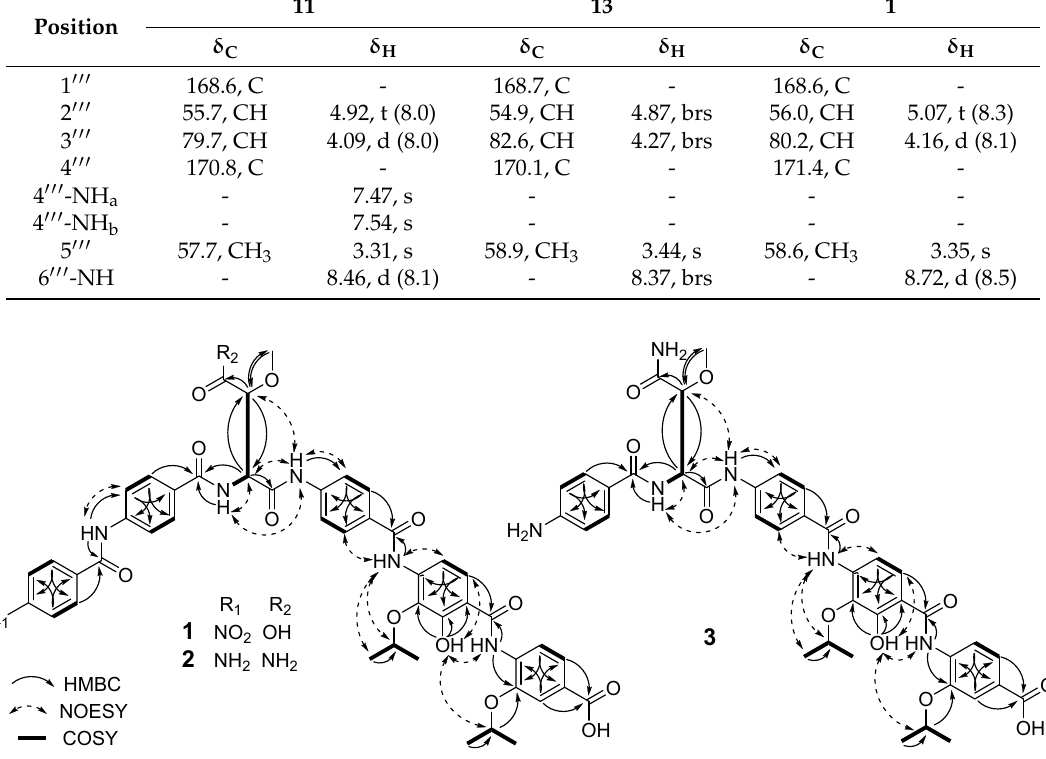
(Figure S19). An unexpected NOE from H-2 (cid:48)(cid:48)(cid:48) to H-3 (cid:48)(cid:48)(cid:48) suggested the presence of the other